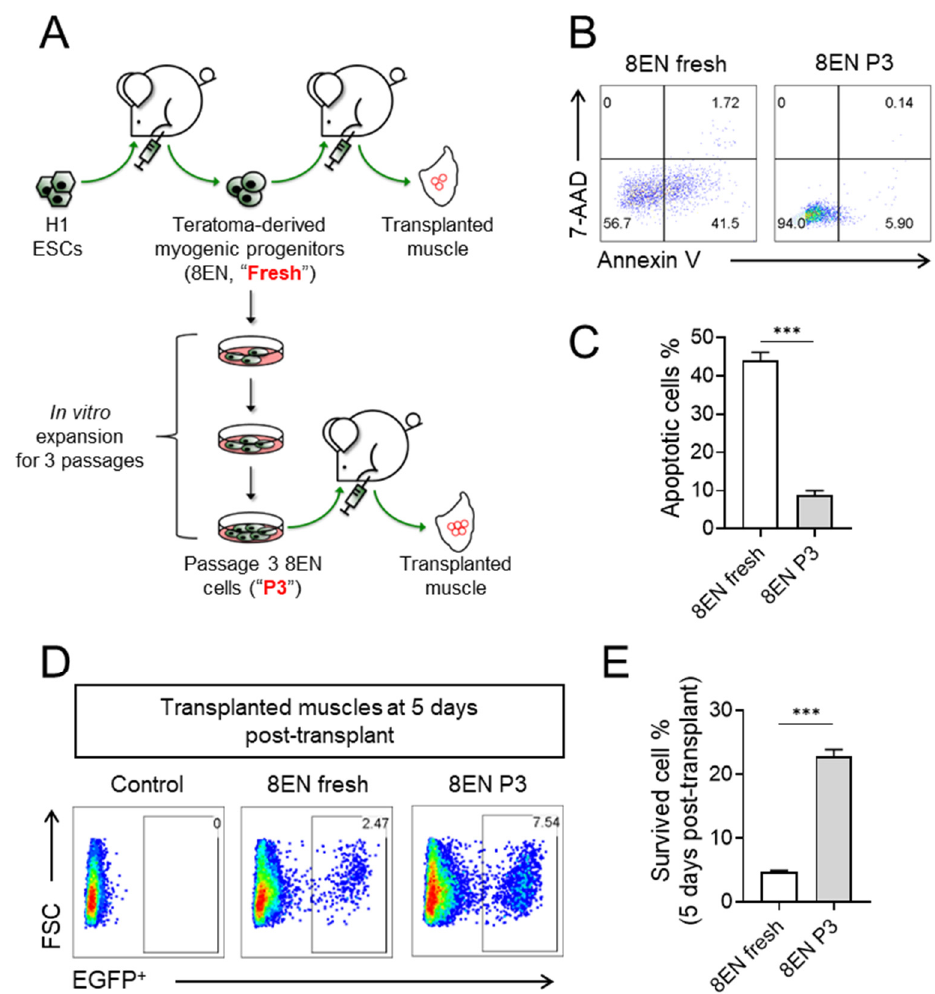
Figure 3. Passaged 8EN skeletal myogenic progenitors improved cell survival in vitro and in vivo. ( A ) Schematic of transplantation of 8EN cells produced from human H1 ESC-derived teratomas. ( B ) FACS analysis and ( C ) quantification (mean ± SEM, 4 biological replicates, *** p < 0.001) of apoptosis: cells expressing 7-AAD and/or Annexin V were considered apoptotic. ( D ) FACS analysis and ( E ) quantification (mean ± SEM, 4 biological replicates, *** p < 0.001) of EGFP + donor cells 5 days after transplantation. The total mononuclear fraction in the transplanted TA muscles was analyzed in ( D ), and the number of EGFP + donor cells was counted. The percentage of survived cells ( E ) was calculated as a ratio of the number of EGFP + donor cells 5 days after transplantation to the number of injected cells (100,000 cells). 8EN: CD82 + ERBB3 + NGFR +